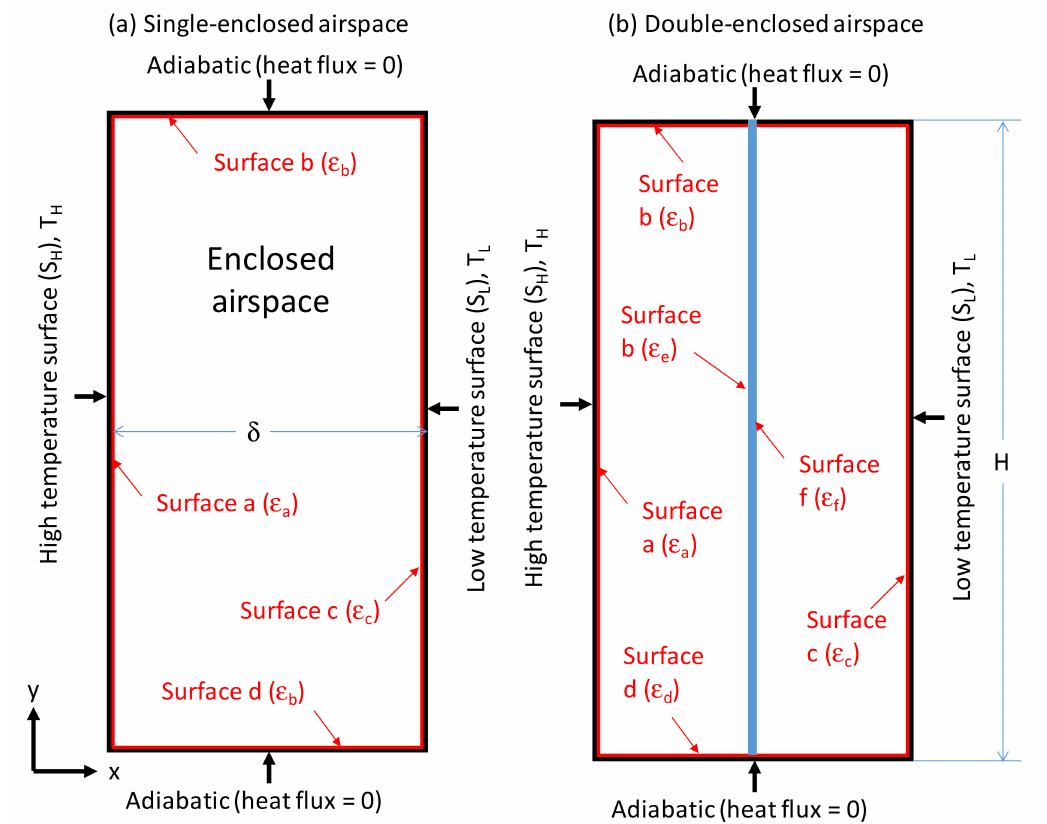
Figure A1. Schematic showing the boundary conditions for single- airspace ( a ) and double airspaces ( b ) involving surfaces of various